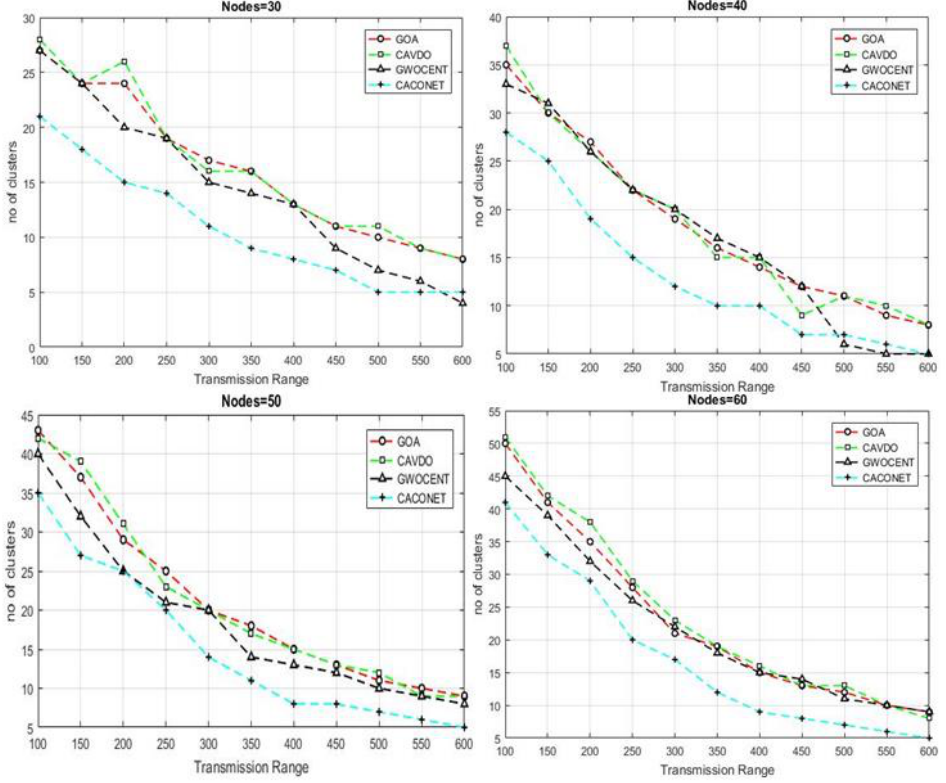
Figure 6. The number of clusters vs. Tx Range for 2 Km 2 × 2 Km 2.